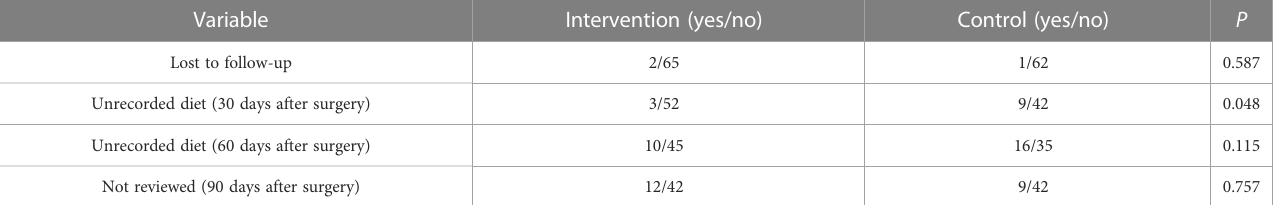
TABLE 2 Evaluation of patient